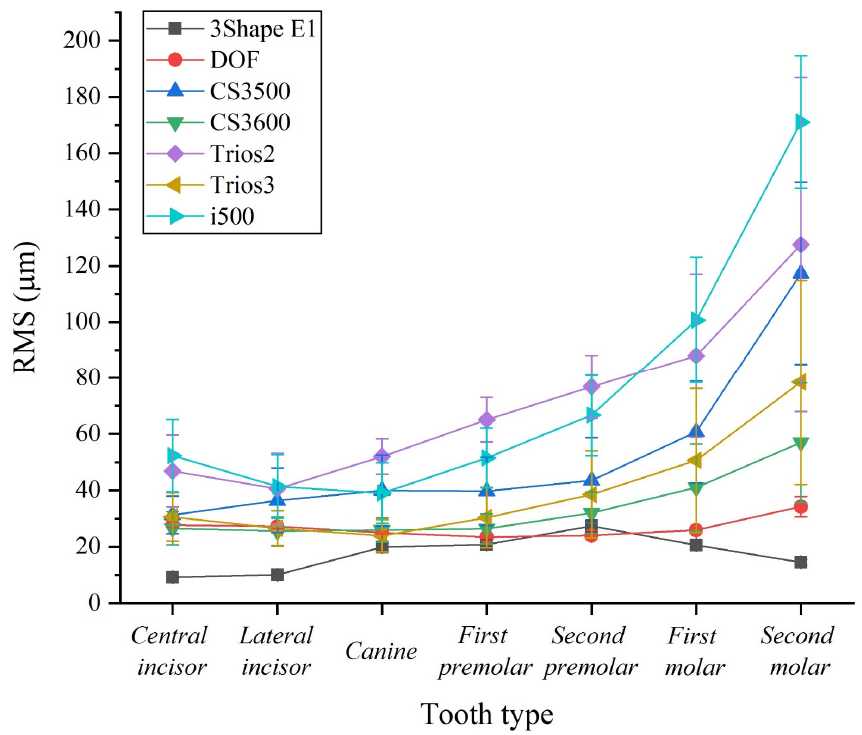
Figure 5. Comparison of the accuracy of 3D scanners according to the tooth type.